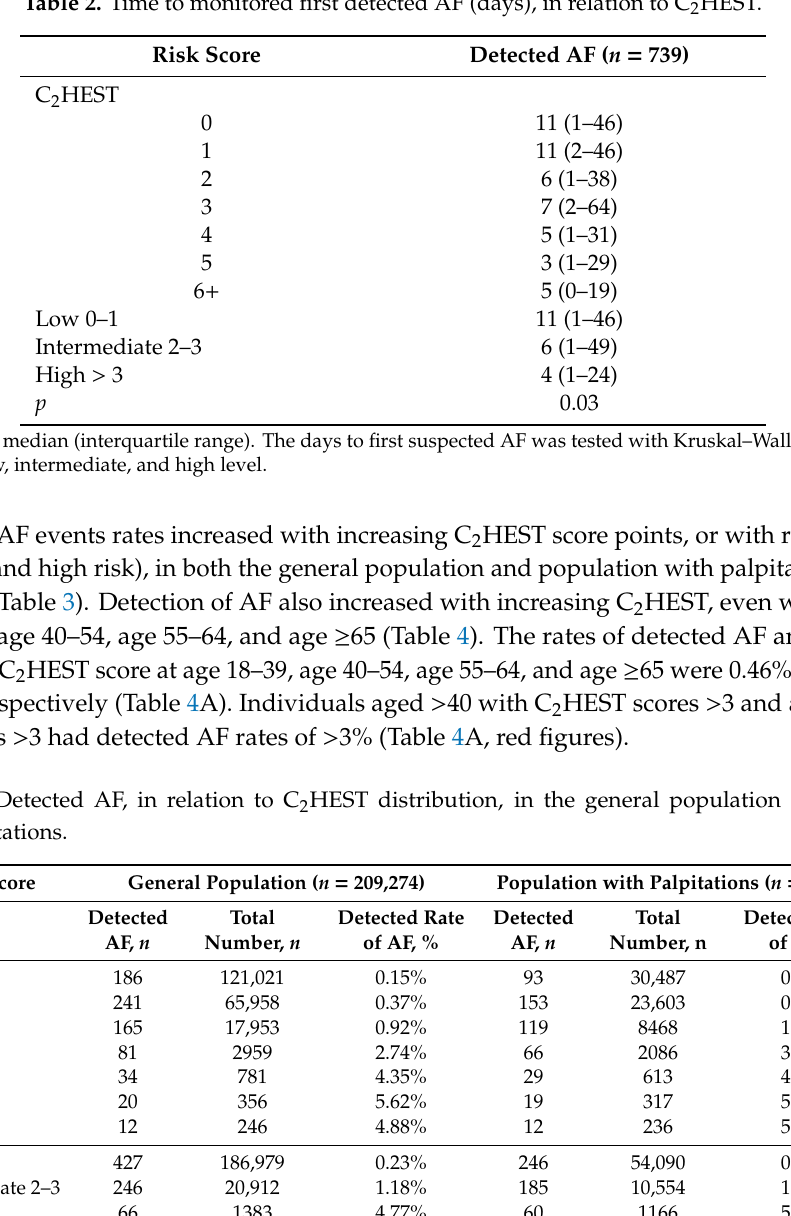
Table 2. Time to monitored first detected AF (days), in relation to C 2 HEST.